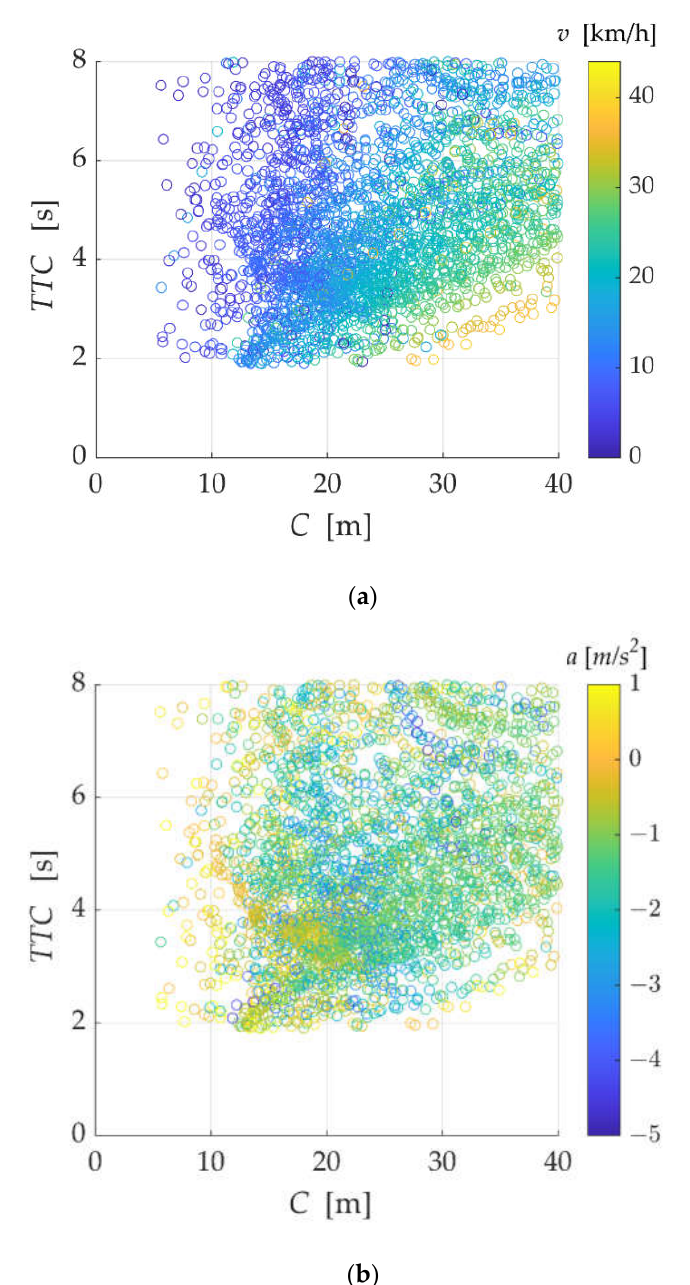
Figure 9. Safety index distribution of the proposed algorithm. ( a ) Distribution with respect to longitudinal velocity, ( b ) distribution with respect to longitudinal acceleration.